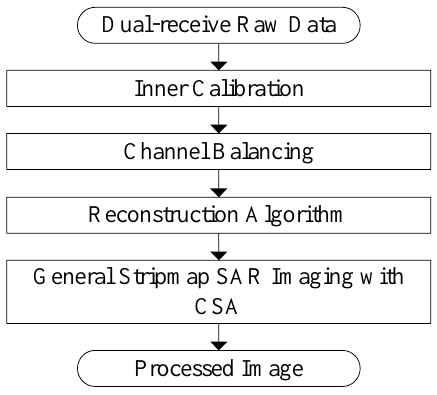
Figure 3. Block diagram of azimuth processing for dual-receiving data of GF-3 ultra-fine stripmap mode.